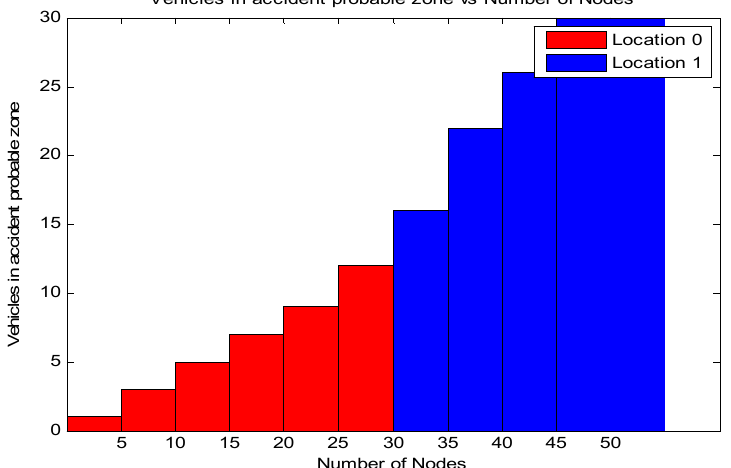
Figure 15. Number of nodes in a probable accident zone vs. number of nodes.